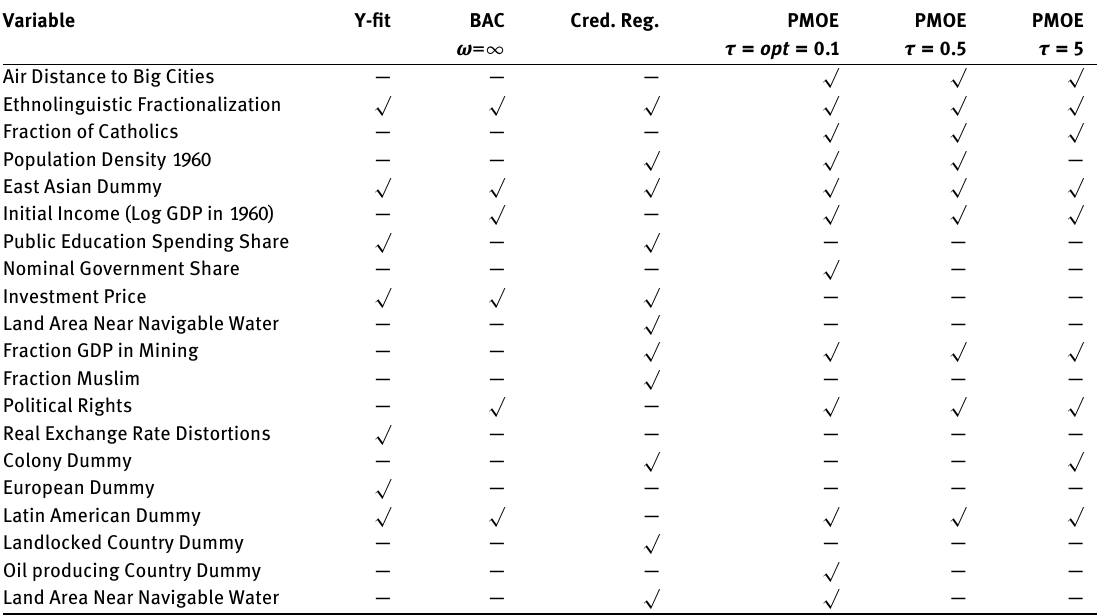
Table 3: The economic growth data: List of significant variables. Variable Y-fit Air Distance to Big Cities Ethnolinguistic Fractionalization Fraction of Catholics Population Density 1960 East Asian Dummy Initial Income (Log GDP in 1960)